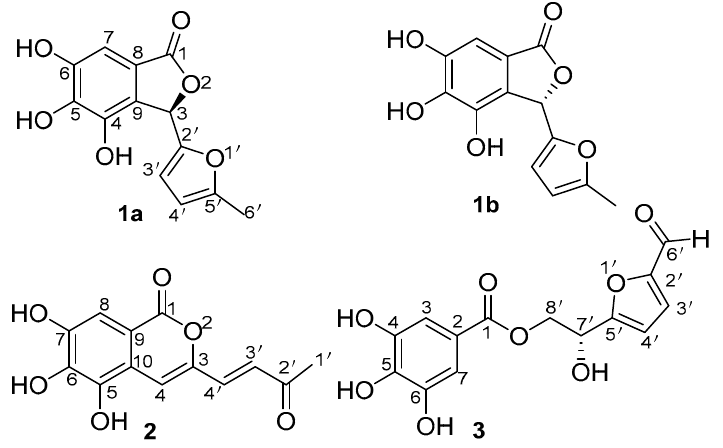
Figure 1. The structures of compounds 1–3. Compounds 1a and 1b were obtained as a mixture, as a yellow columnar single crystal (MeOH). The molecular formula C 13 H 10 O 6 was deduced from the quasimolecular ion peak at m/z 285.0354 [M + Na] + (calculated for 285.0375, C 13 H 10 O 6 Na) in the HRESIMS with an unsaturation of nine. The UV spectrum of compound 1 showed an absorption maximum at 223, 279 nm. The IR spectrum displayed the presence of hydroxyl (3362 cm − 1 ) and carbonyl (1717, 1616 cm − 1 ) groups. The 1 H-NMR data of compound 1 (Table 1) indicated the presence of one methyl group at δ H 2.24 (3H, s, H-6 ′ ); three methine protons, including two olefinic methines at δ H 5.98 (1H, d, J = 2.6 Hz, H-4 ′ ) and 6.22 (1H, d, J = 2.8 Hz, H-3 ′ ); one oxygenated methine at δ H 6.34 (1H, s, H-3); one aromatic ring hydrogen at δ H 6.85 (1H, s, H-7). 13 C-NMR data gave 13 carbons, including the following: one methyl, δ C 13.2 (C-6 ′ ); one carbonyl carbon, δ C 173.2 (C-1); one oxygenated methine, δ C 75.4 (C-3); four olefinic carbons, δ C 107.3 (C-4 ′ ), 112.2 (C-3 ′ ), 148.4 (C-2 ′ ), and 154.5 (C-5 ′ ); a group of aromatic carbons, δ C 103.0 (C-7), 117.5 (C-8), 127.1 (C-9), 141.3 (C-5), 141.4 (C-4), and 149.0